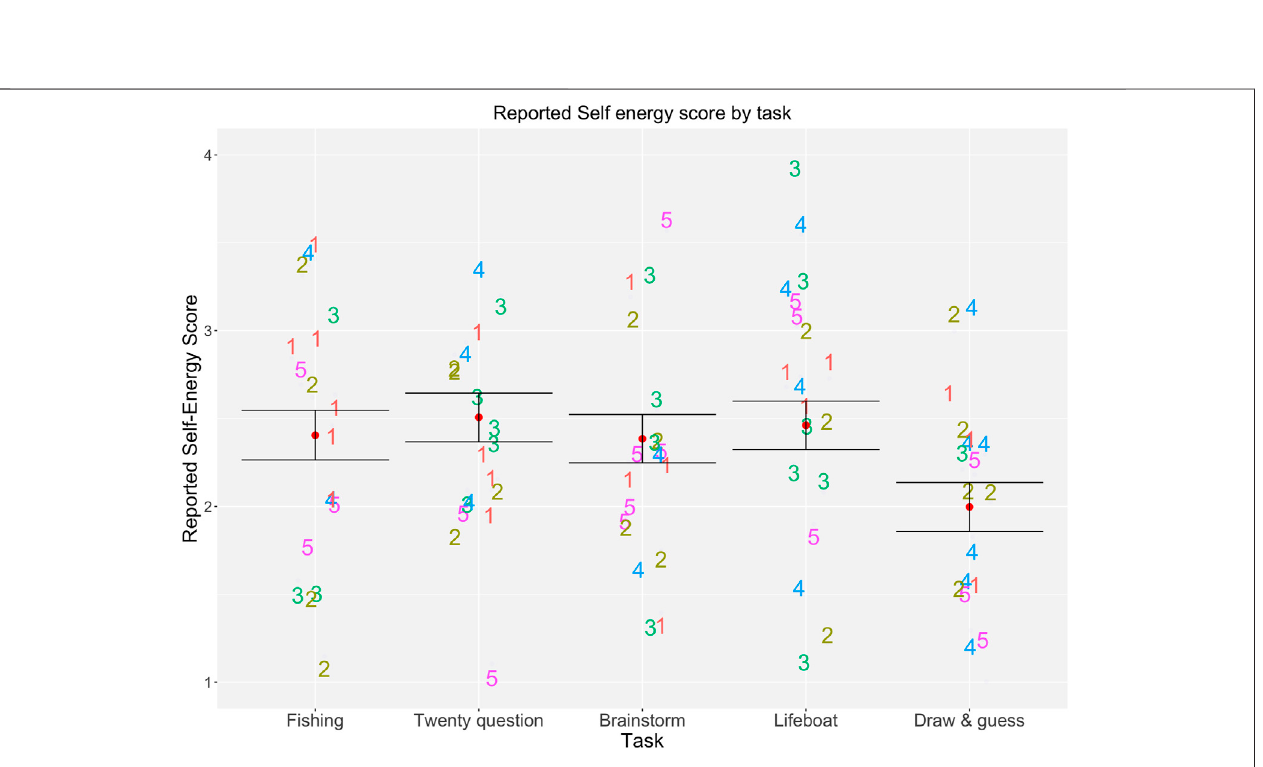
Frontiers in Virtual Reality |